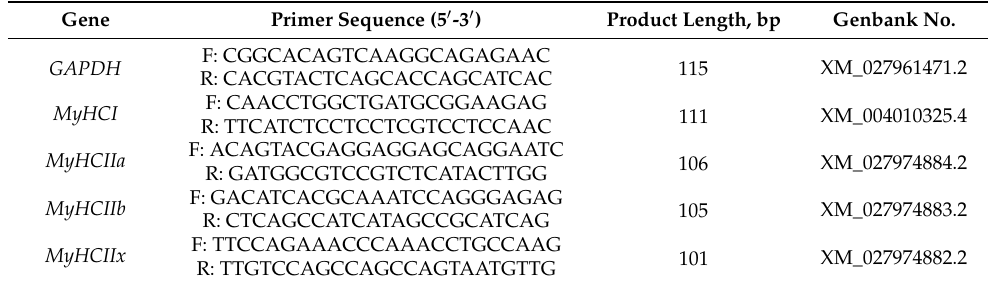
Table 3. Primers used for real-time quantitative